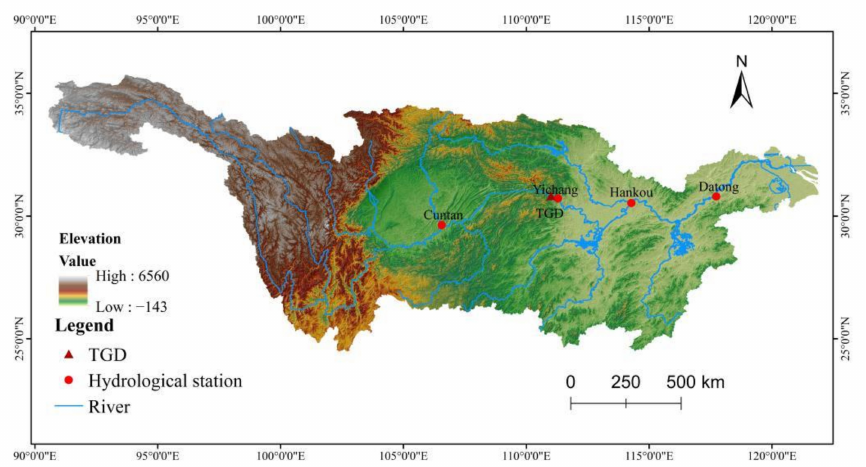
Figure 1. Location of the study region and the hydrological